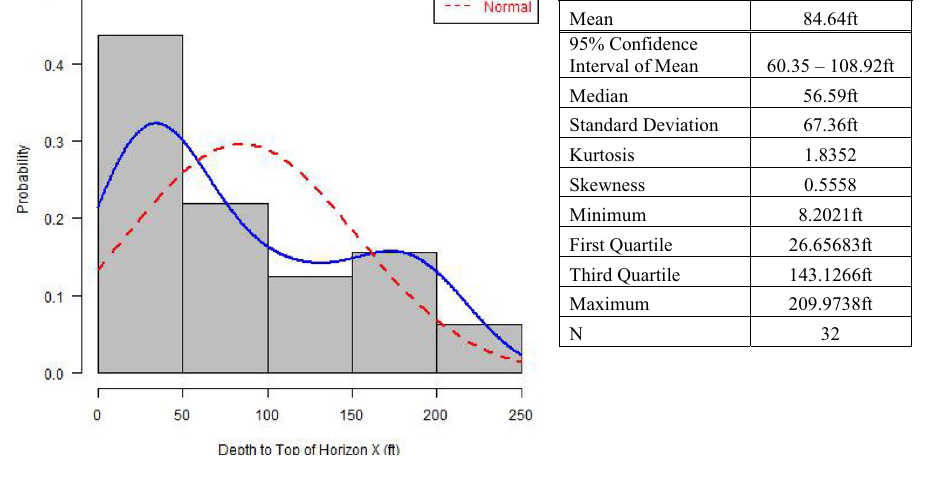
and distributions of depths to top of Horizon X